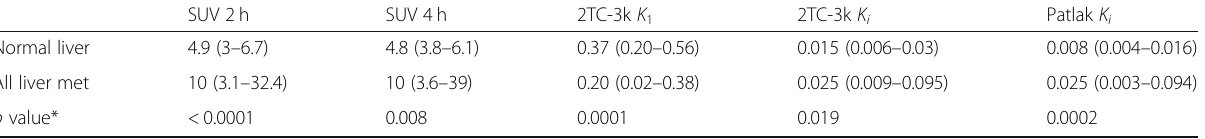
Table 2 68 Ga-ABY-025 SUVs and parametric image values in normal liver and liver metastasis, median